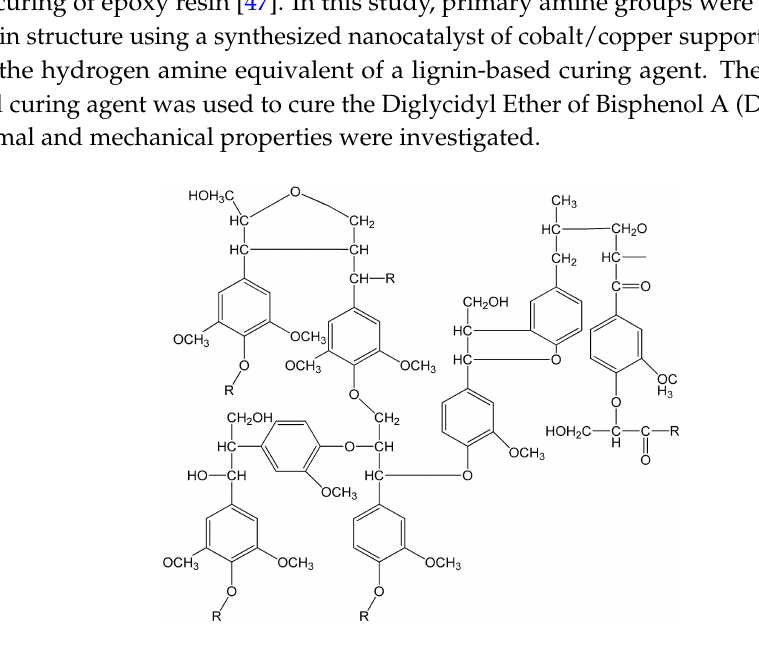
Figure 1. Proposed chemical structure for lignin